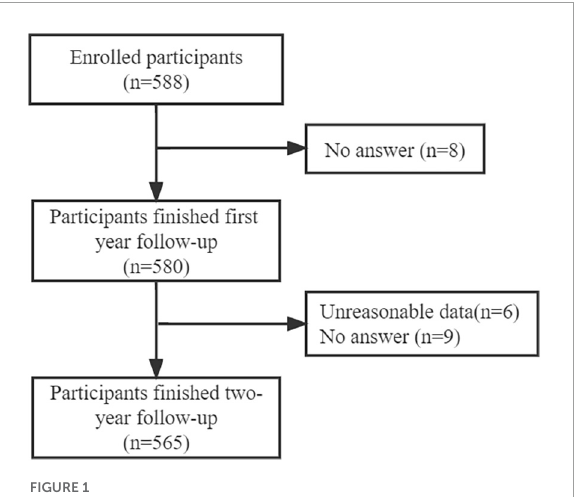
FIGURE1 Flow chart of the participants at baseline, 1- and 2-year